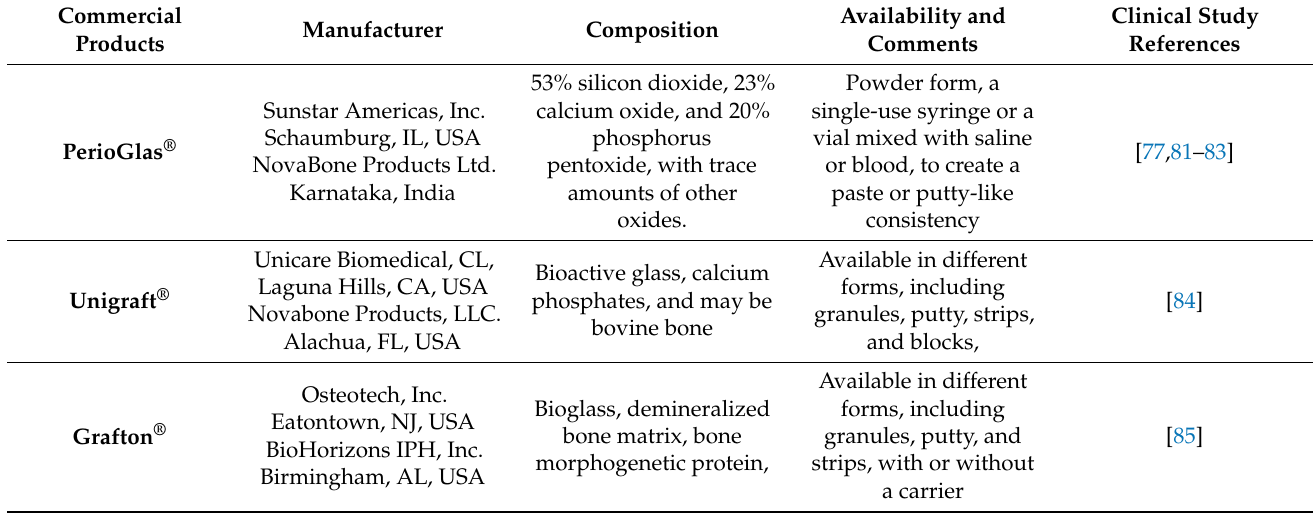
Table 1. Commercially available bioactive glasses for periodontal